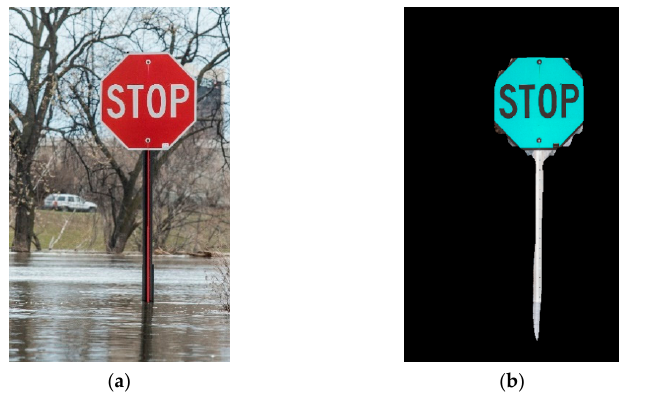
Figure 8. Illustration of the mirror reflection scenario: ( a ) the input image; ( b ) the output image with an extended masked object.